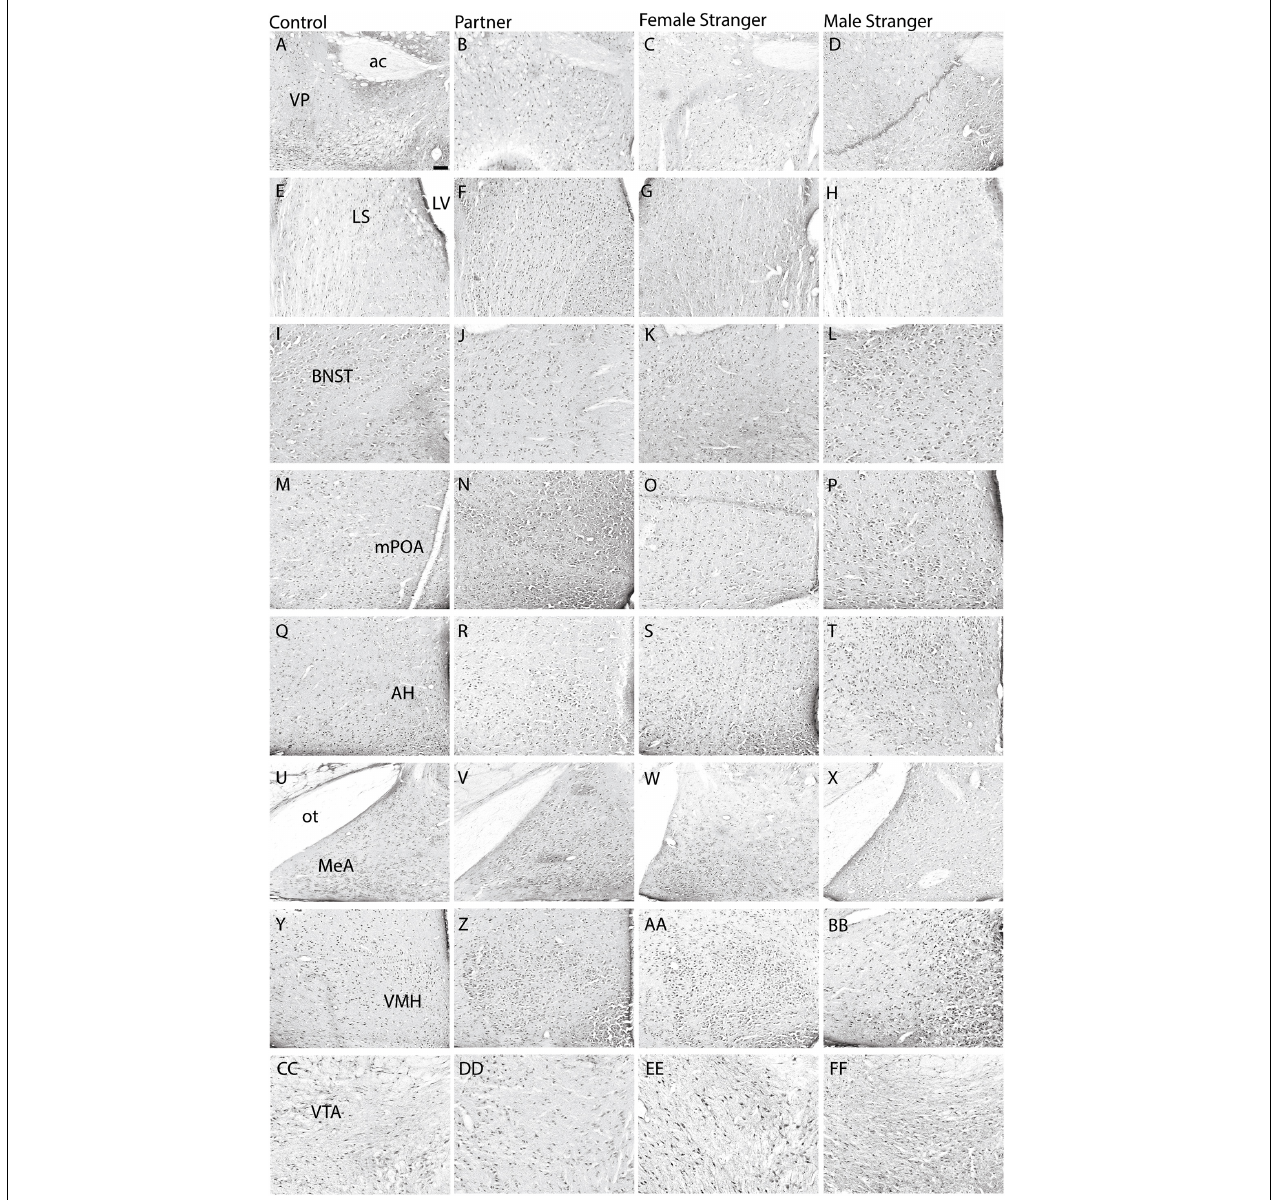
FIGURE 2 | Representative images are displayed for each condition per region in order from control (A,E,I,M,Q,U,Y,CC) , partner (B,F,J,N,R,V,Z,DD) , opposite-sex stranger (C,G,K,O, S,W,AA,EE) , and same-sex stranger (D,H,L,P,T,X,BB,FF) (ac. anterior commissure; LV. lateral ventricle; ot. optic tract). Scale bar = 100 µ m in control images (applies to all other